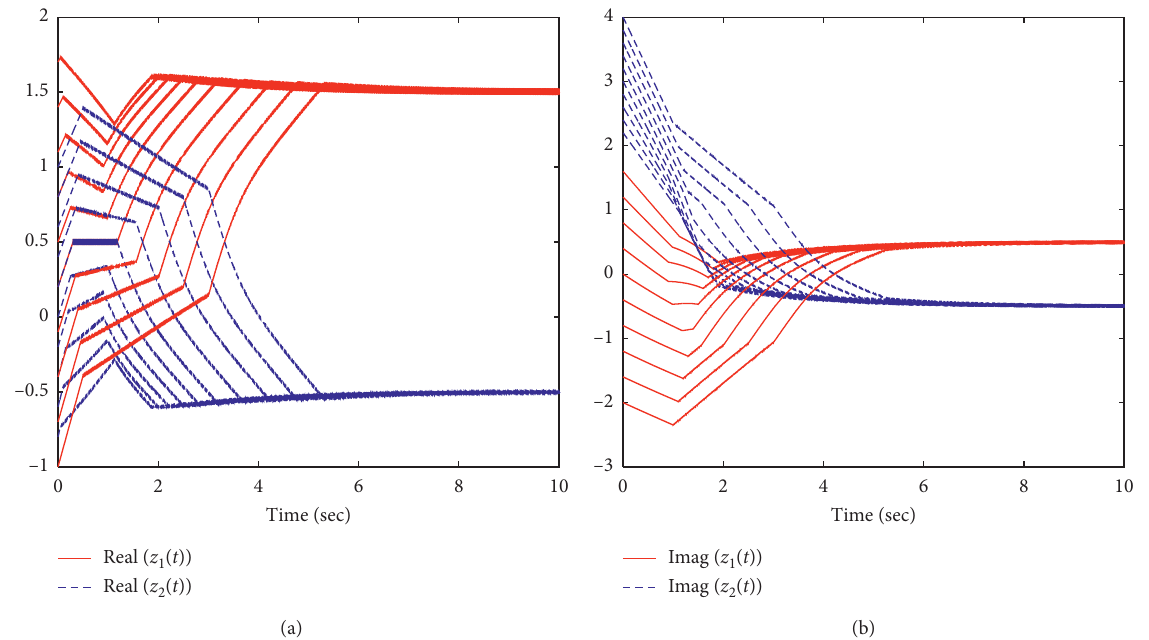
Figure 1: The state variables ω ( t ) with ten arbitrary initial states for Example